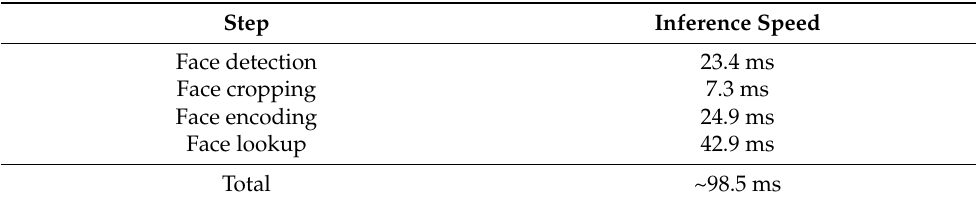
Table 2. Timing measurement of the pipeline inferencing with NVIDIA GeForce GTX2080 graphic card.